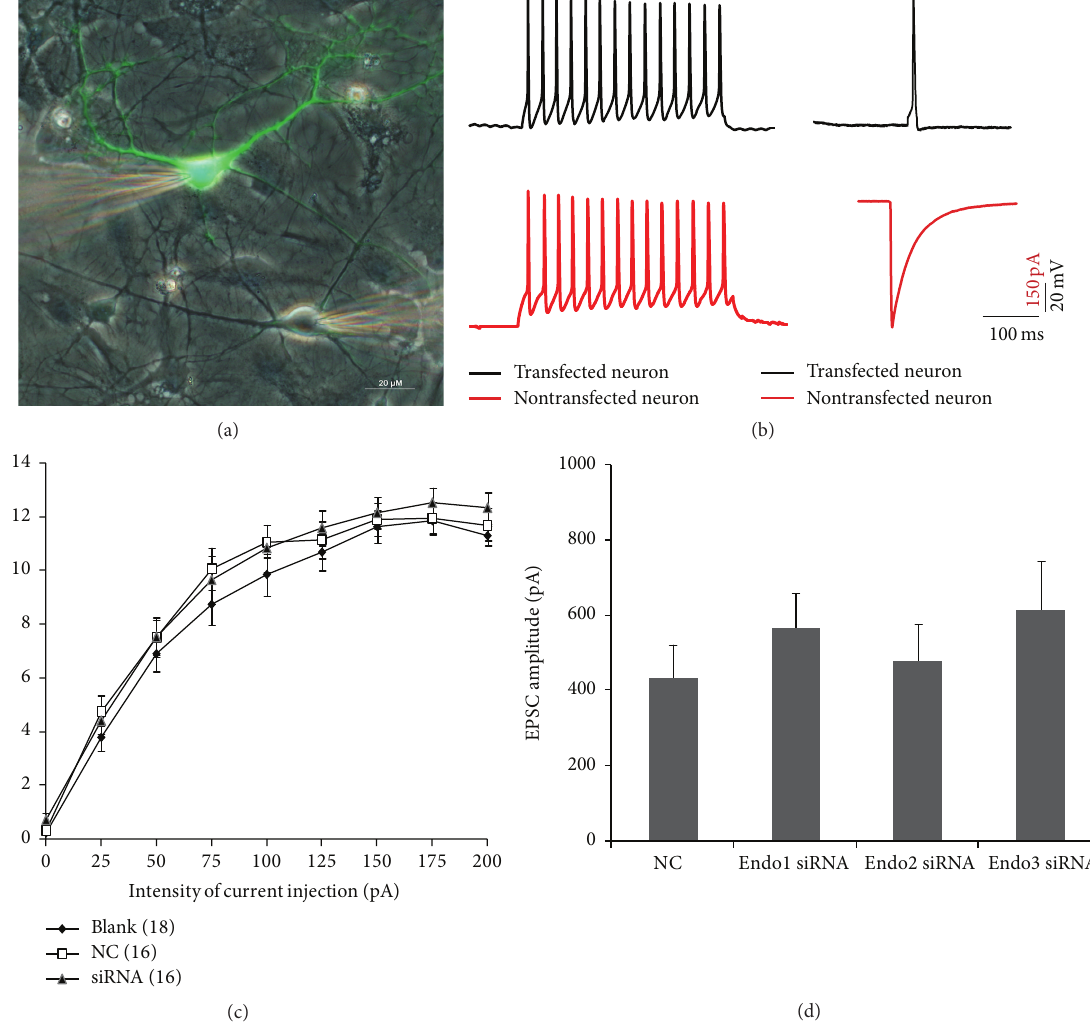
Figure 2: Basic electrophysiological characteristics and evoked excitatory postsynaptic currents (EPSCs) of transfected neurons. (a) Dual- cell patch-clamp recorded hippocampal neurons transfected with siRNA or a scrambled sequence (negative control, NC) (left, green) and nontransfected neurons (right, gray). (b) Representative traces from neurons. Transfected and nontransfected neurons exhibit many